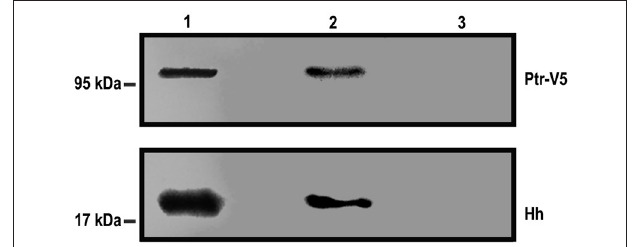
FIGURE 6 | Hh can precipitate Ptr-V5. Hh and Ptr-V5 expression vectors were transfected into S2 and cl-8 cells, respectively. A premix of an S2-HhN-conditioned medium and a lysate of cl-8 cells overexpressing the Ptr -V5 fusion protein (an input sample) was immunoprecipitated with anti-V5 or anti-c-Myc antibodies, each one adsorbed into goat anti-mouse IgG Dynabeads. The input sample (Lane 1) and the eluents from immunoprecipitation with anti-V5 (Lane 2) or anti-c-Myc (Lane 3) were analyzed with Western blotting using anti-V5 and anti-Hh antibodies. These antibodies recognized, respectively, Ptr and Hh contained in the immunocomplex. As expected, the anti c-Myc that was used as the immunoprecipitation control gave no signals.